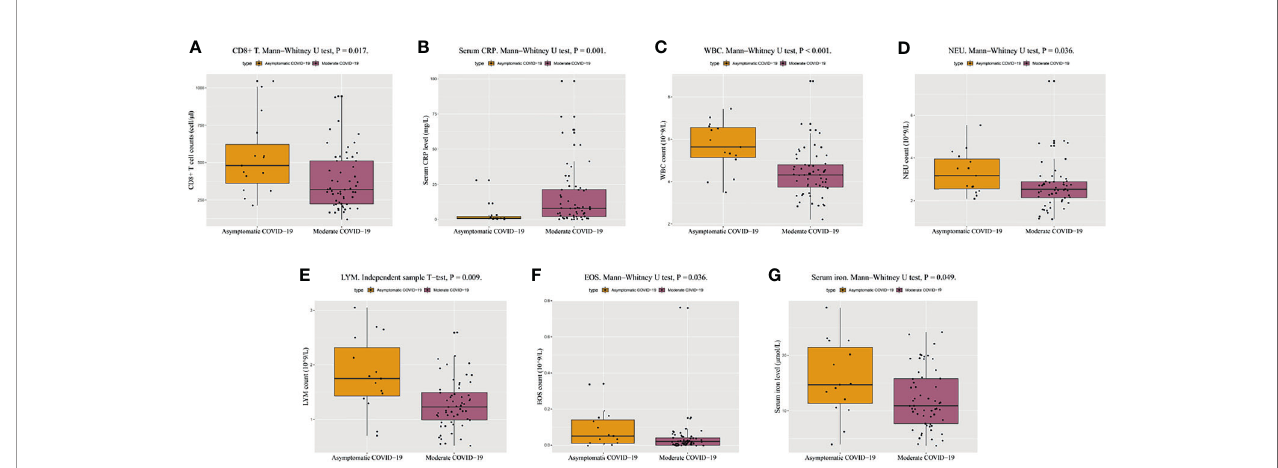
FIGURE 1 | Clinically relevant biochemical results at admission for patients with asymptomatic COVID-19 and moderate COVID-19. (A – G) Differences in CD8+ T cell counts, CRP, WBC counts, NEU counts, LYM counts, EOS counts, and serum iron between patients with asymptomatic COVID-19 and patients with moderate COVID-19. P < 0.05 is considered signi fi cant. COVID-19, coronavirus disease 2019; CRP, C-reactive protein; EOS, eosinophil; LYM, lymphocyte; NEU, neutrophil; WBC, white blood